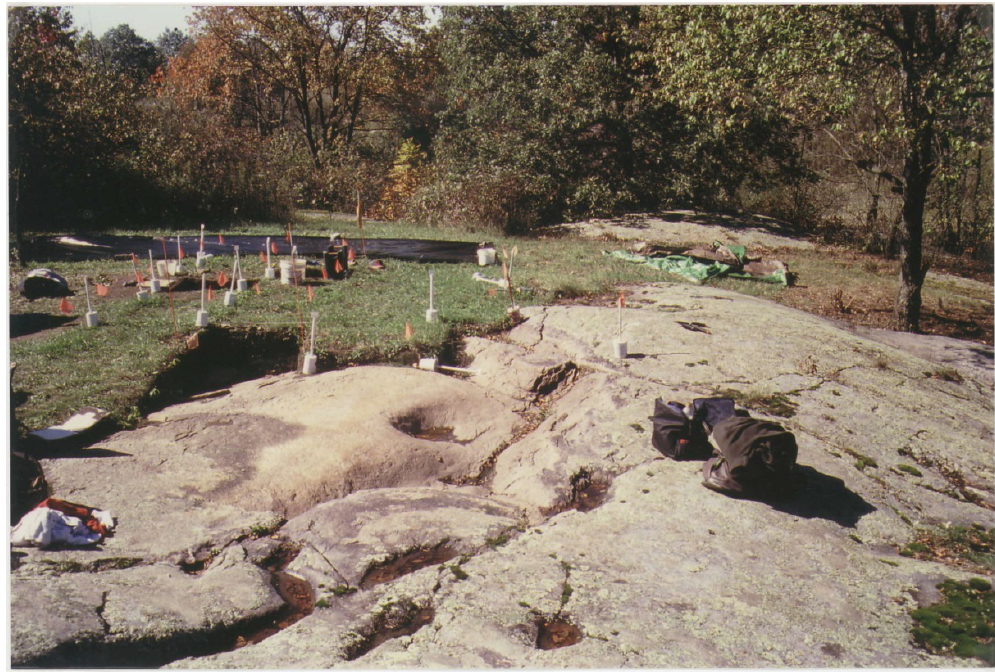
Figure 3. Initial excavations at the Hensler Site, 2005. The soil mantle lies 6m from the decorated seam of Andalusite Schist. Photo by author